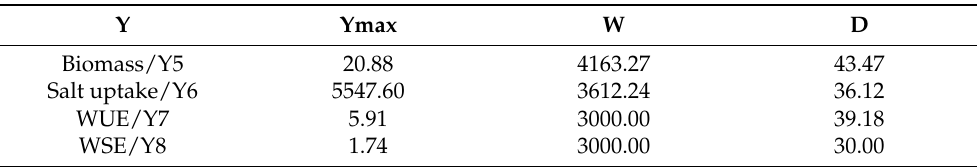
Table 8. Maximum theoretical values for each evaluation indicator and the corresponding irrigation and density